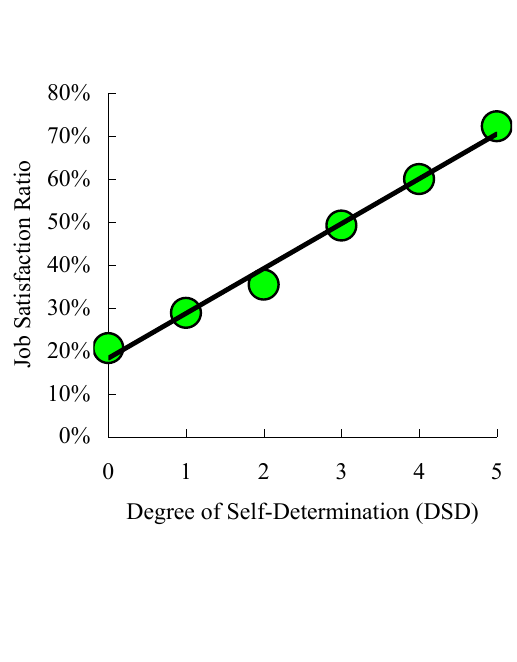
Figure 1. Graph of the Job Satisfaction Ratio Versus the Degree of Self- Determination